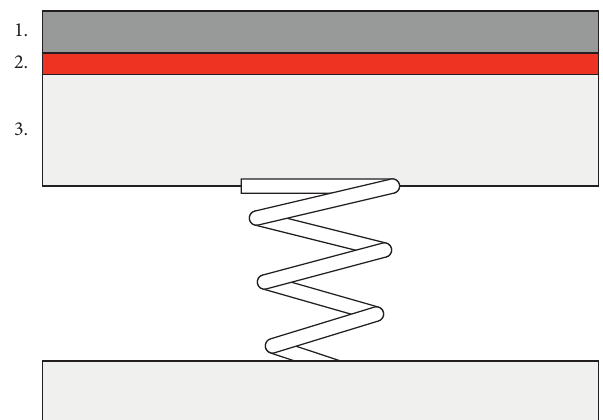
Figure 2: Sensor cross section (1—rubber layer, 2—PVDF film, 3—alumina plates with spring